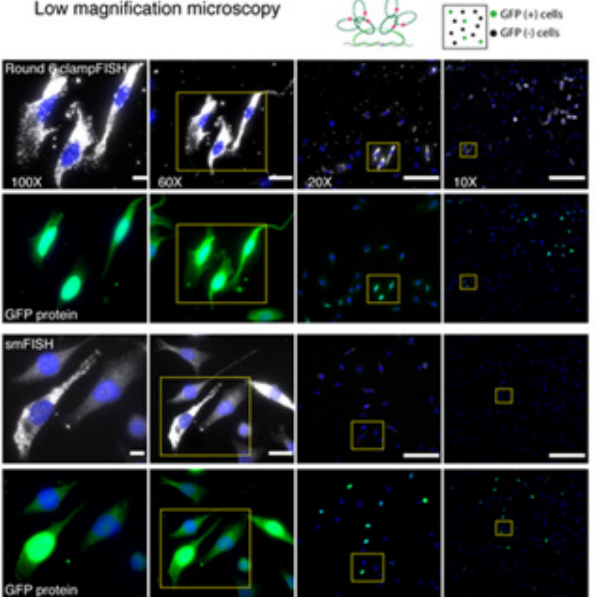
Figure 6. Application of Clamp FISH on population of cells. In the picture is shown the application of Clamp FISH in detection of GFP mRNA in diverse population of cells with expression or non- expression of examine gene. Cells are captured on different magnification levels [54].